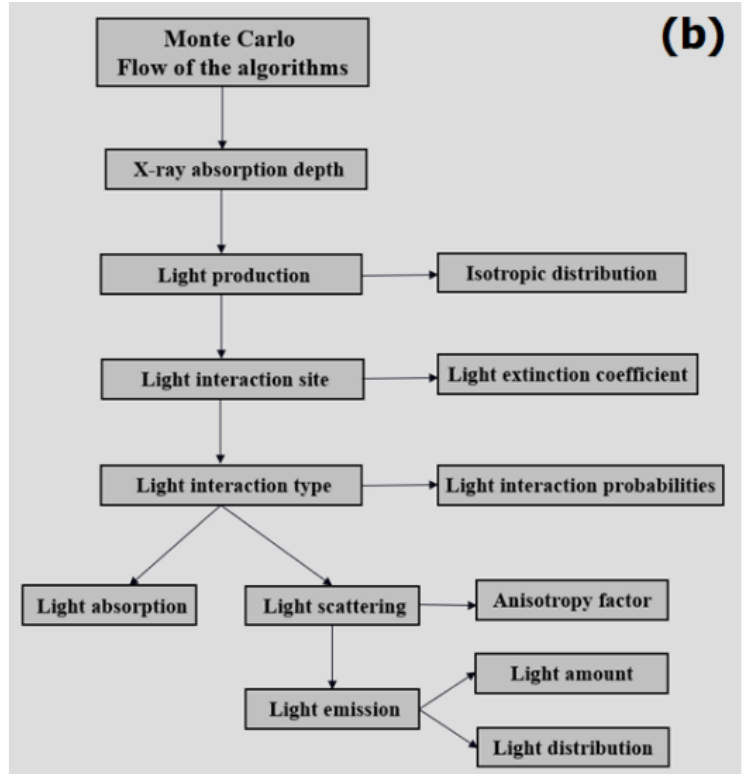
Figure 4. A schematic illustration of the basic structural aspects of the Monte Carlo model: ( a ) input data and output results; ( b ) the flow of the Monte Carlo algorithms.